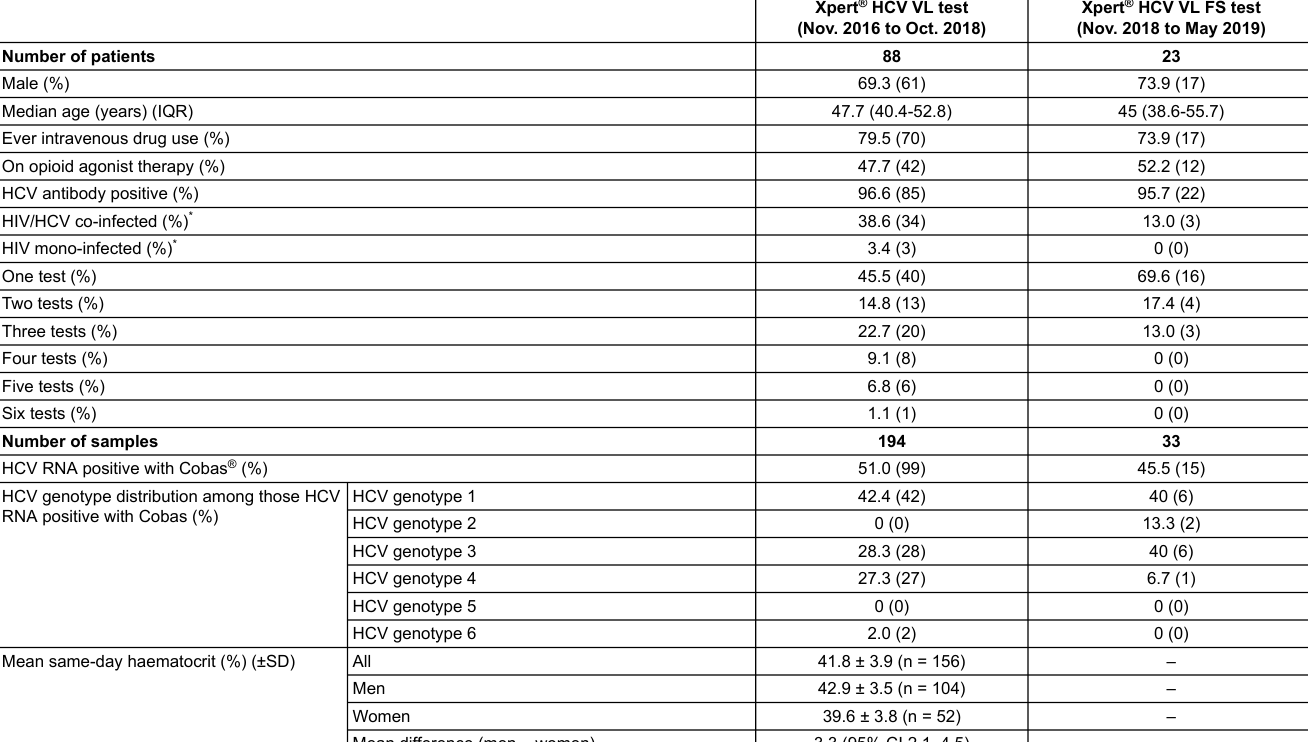
Table 1: Patient/sample characteristics.